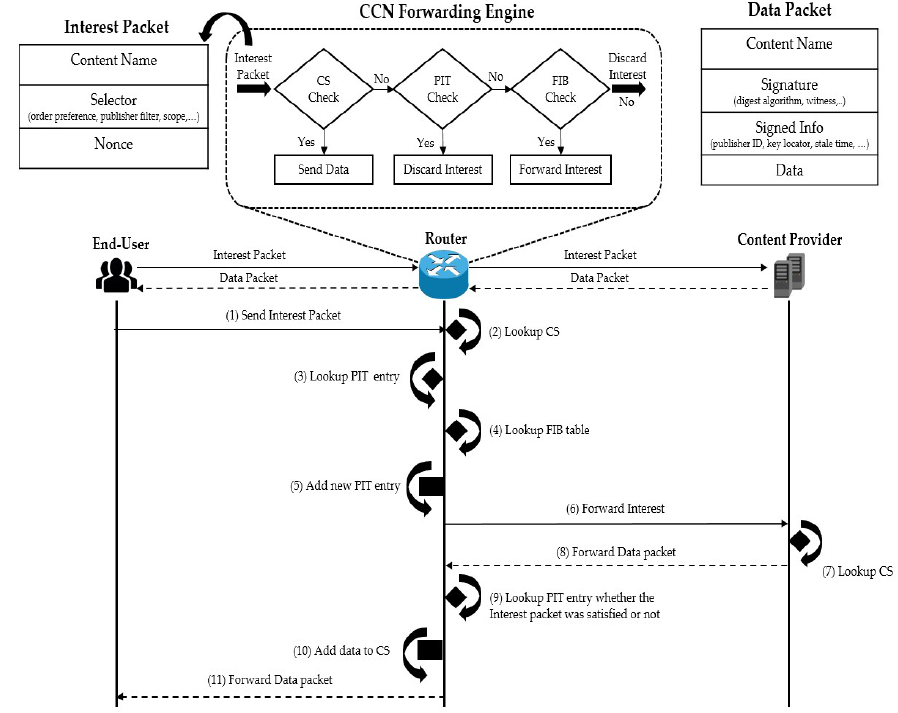
Figure 2. CCN communication mechanism.